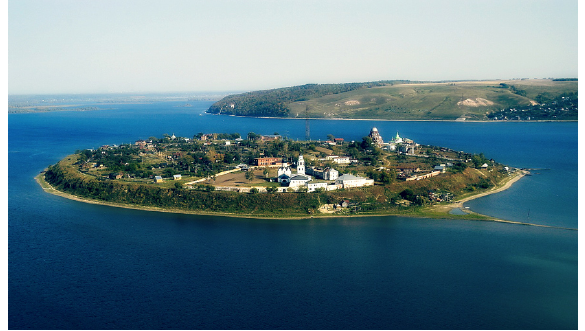
Figure 3. Sviyazhsk, birdseye